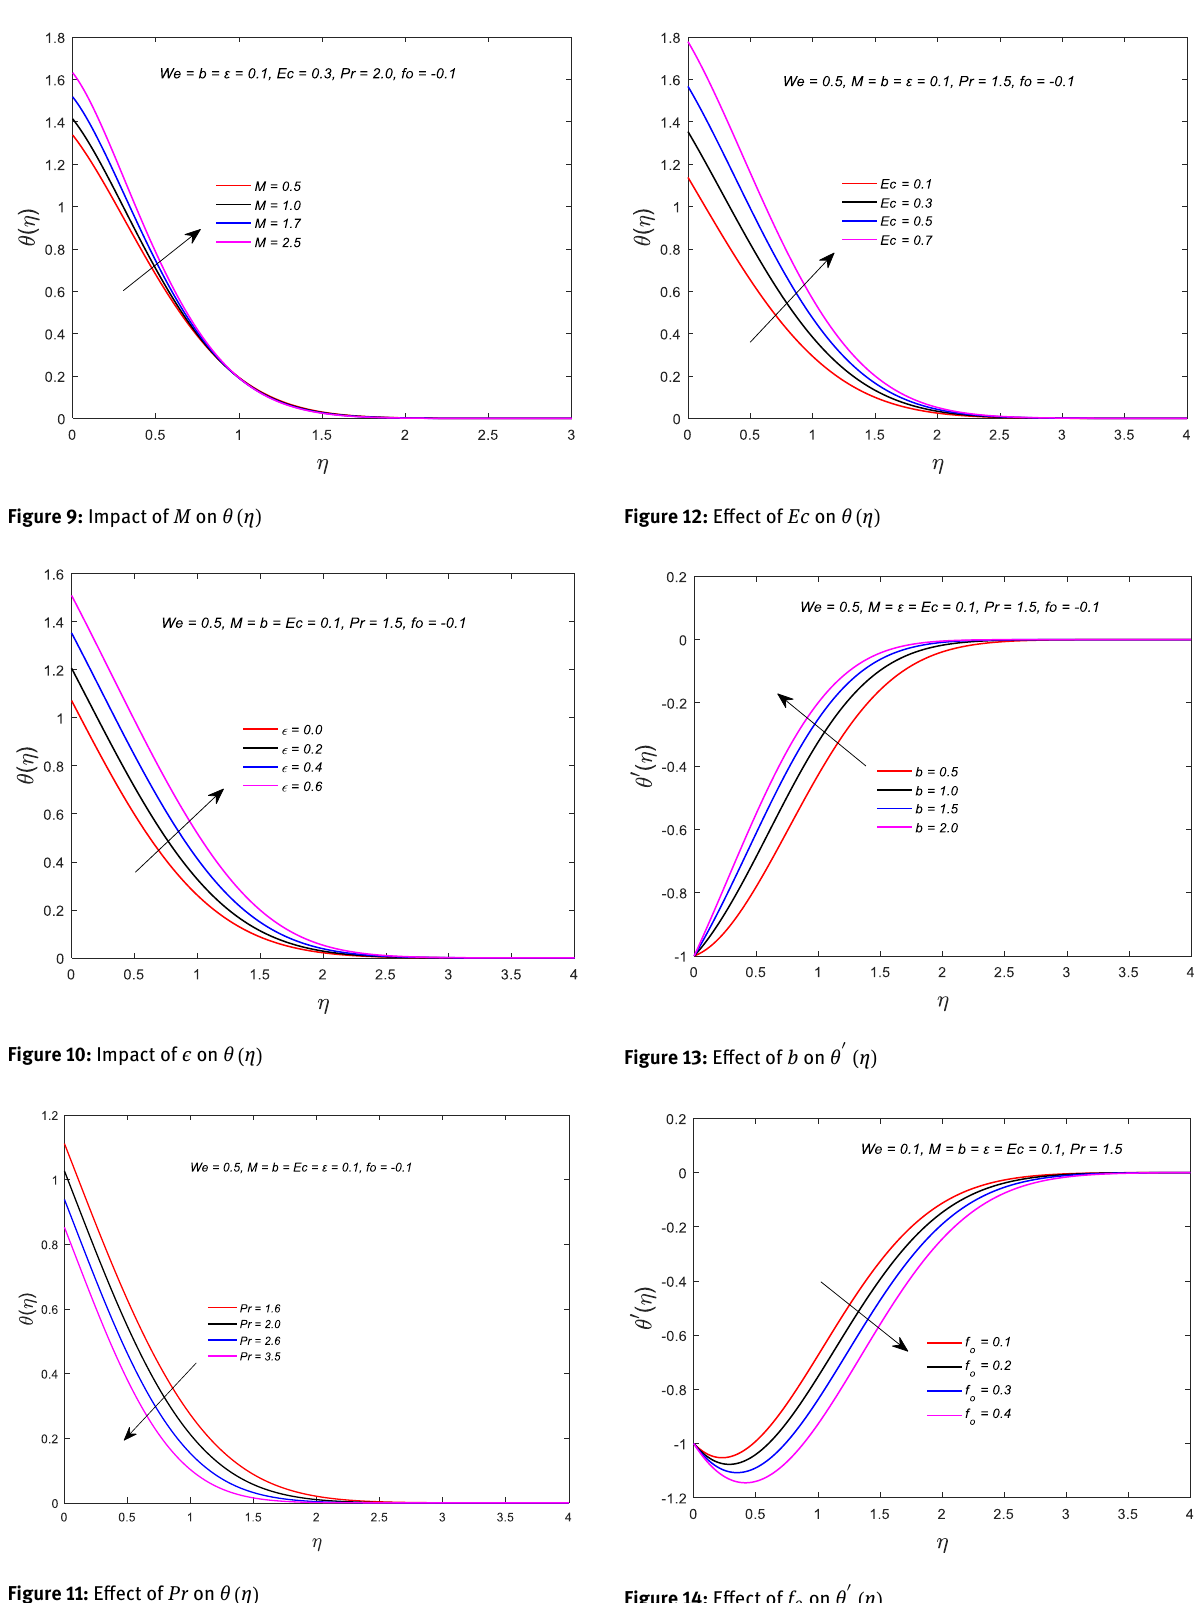
Figure 14: Effect of f o on θ (cid:48) ( η